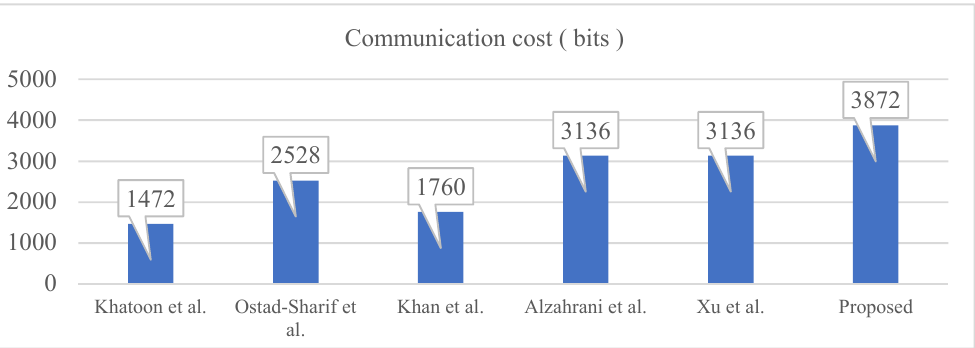
Figure 6. Communication cost comparison. Figure 6.